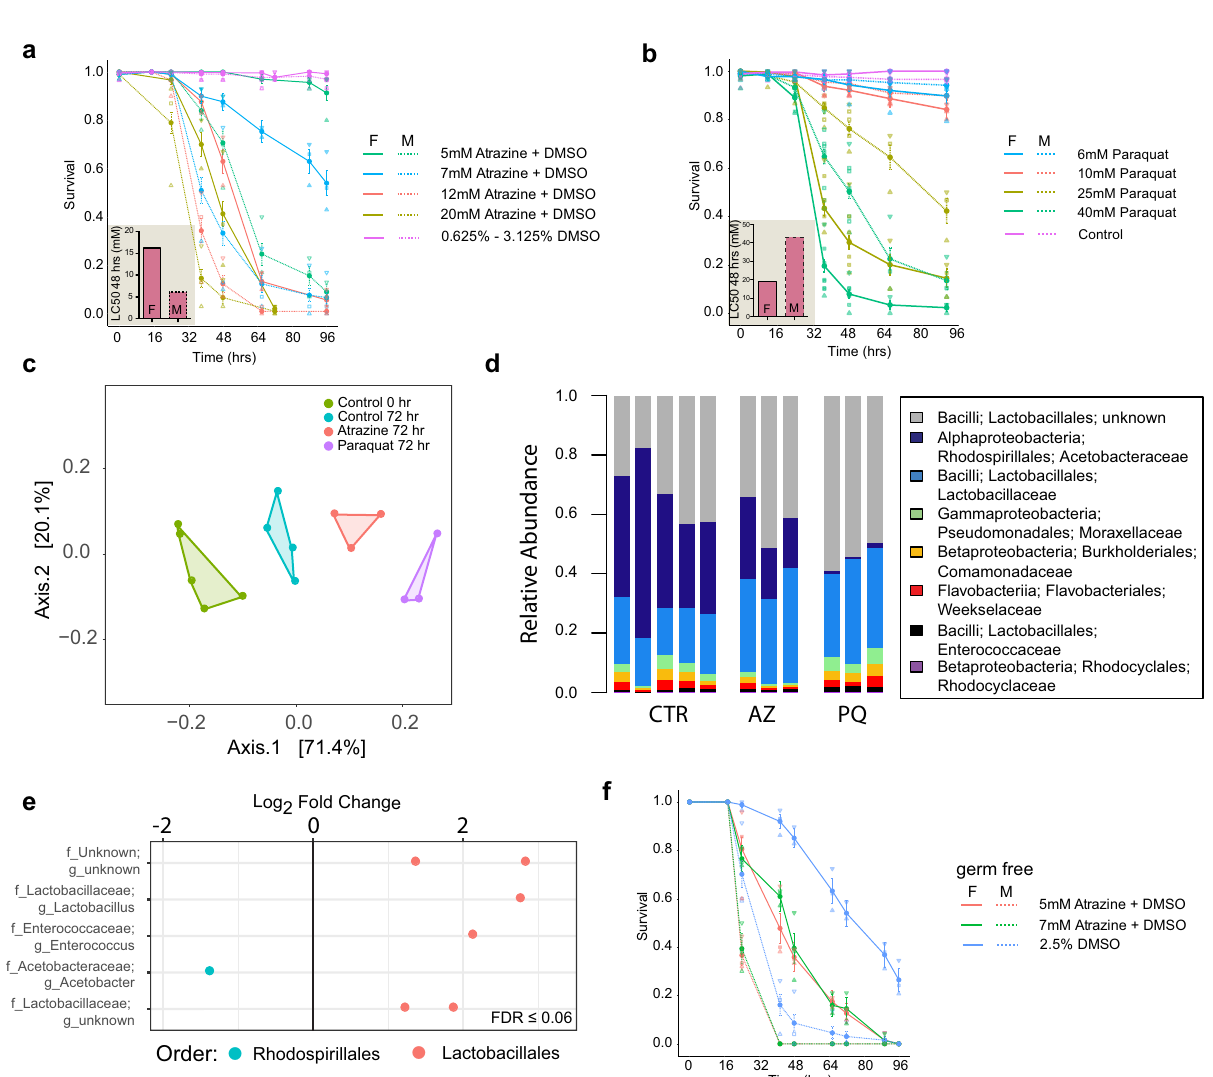
Fig. 2 Effect of atrazine and paraquat on survival and gut microbiome in Drosophila melanogaster . Effects of exposures on host and microbiome. a Host survival curves in response to 5 − 20 mM atrazine exposures. LC50 at 48 h is 16 mM for females and 7 mM for males. For each dose, we used 30 males and 30 females in triplicate aged 4 − 5 days post eclosion. Error bars indicate the standard deviation across replicates. b Host survival curves in response to 6 − 40 mM paraquat exposures. LC50 at 48 h is 19 mM for females and 43 mM for males. For each dose, we used 30 males and 30 females in triplicate aged 4 − 5 days post eclosion. Error bars indicate the standard deviation across replicates. c Principal component analysis of microbial abundance levels in control, atrazine, and paraquat treated fl ies. The control 0 and 72 h groups are closer to each other than the atrazine and paraquat groups at 72 h. d Bar charts showing the relative abundance of bacterial families in control ( n = 5), 2 mM atrazine treated ( n = 3) or 8 mM paraquat treated ( n = 3) fl ies at 72 h after treatment. response to atrazine and paraquat. Both herbicides show a reduction in the amount of the Rhodospirillales grp and an increase in the Lactobacillales group. e Log 2 fold change at the genus level for bacteria signi fi cantly changed after treatment with atrazine (FDR < 0.06). Bacteria are color- coded at the order level. f Germ-free host survival curves in response to 5 and 7 mM atrazine exposure. For each dose, we used 30 males and 30 females in triplicate aged 4 − 5 days post eclosion. Error bars indicate the standard deviation across